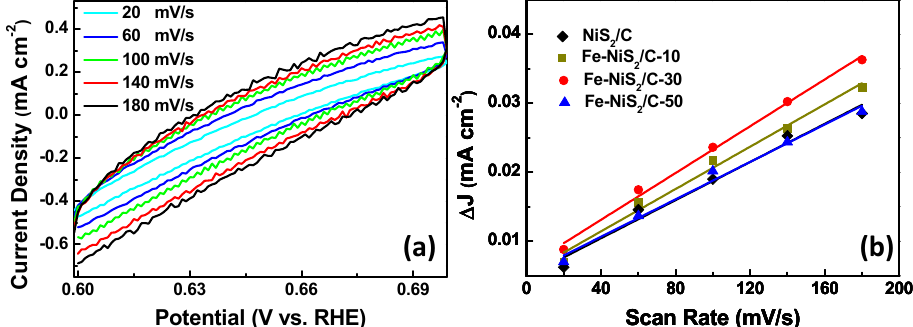
Figure 7. ( a ) Cyclic voltammograms recorded within the potential range of +0.600–0.700 V (vs. RHE) for the Fe-NiS 2 /C-30 sample. ( b ) The plots of current density difference ( Δ J = j a – j c ) at +0.650 V (vs. RHE) against the potential scan rate. The linear curves are the corresponding linear fittings for evaluating C dl .